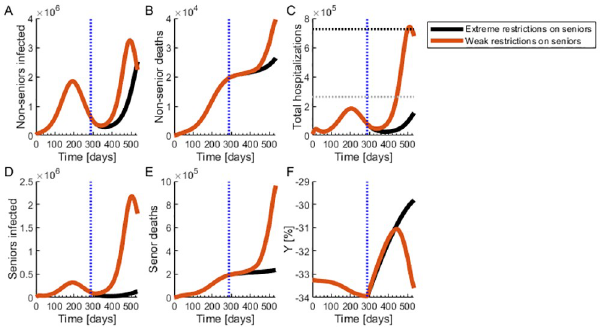
Fig 4. Progressive release of the non-senior population with extremely strict isolation measures for the seniors. ( A ) Number of infected non-seniors. ( B ) Non-senior deaths. ( C ) Total hospitalizations. The gray dotted line marks the hospital capacity strain level and the black dotted line marks the saturation level. ( D ) Number of infected seniors. ( E ) Number of senior deaths. ( F ) Change in economic output compared to the pre-pandemic state. ( A-F ) The black curve represents the scenario where the isolation policies for the seniors are extreme. The red curve represents the scenario where the policy is weakly implemented and the isolation measures for the senior population are not extreme. The vertical blue dotted lines mark the time at which isolation policies are